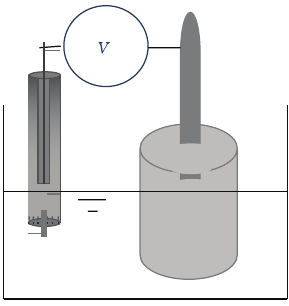
Figure 1: Half-cell potential setup.